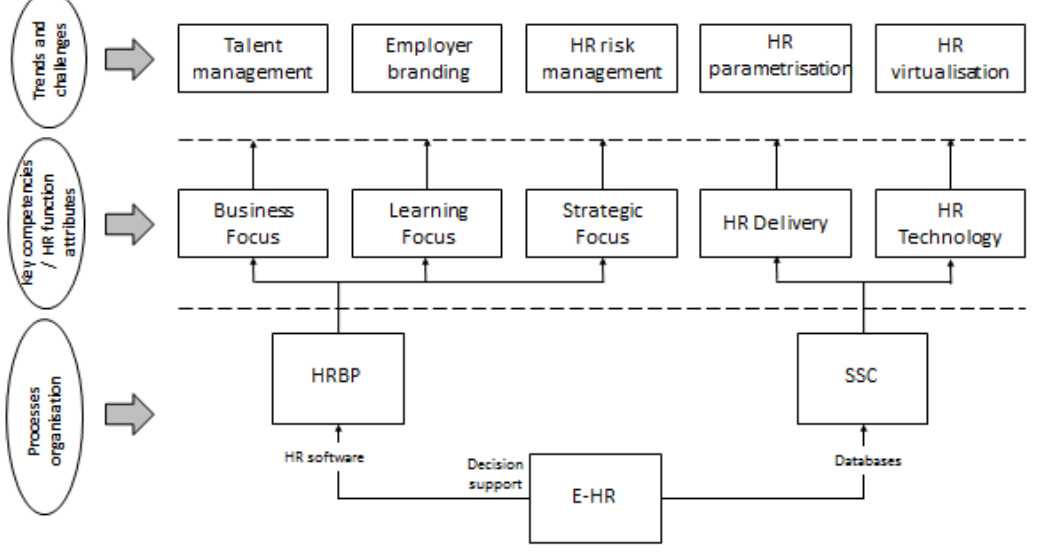
Figure 3. Schematic diagram of the HR function organization. Source: authors’ original work.